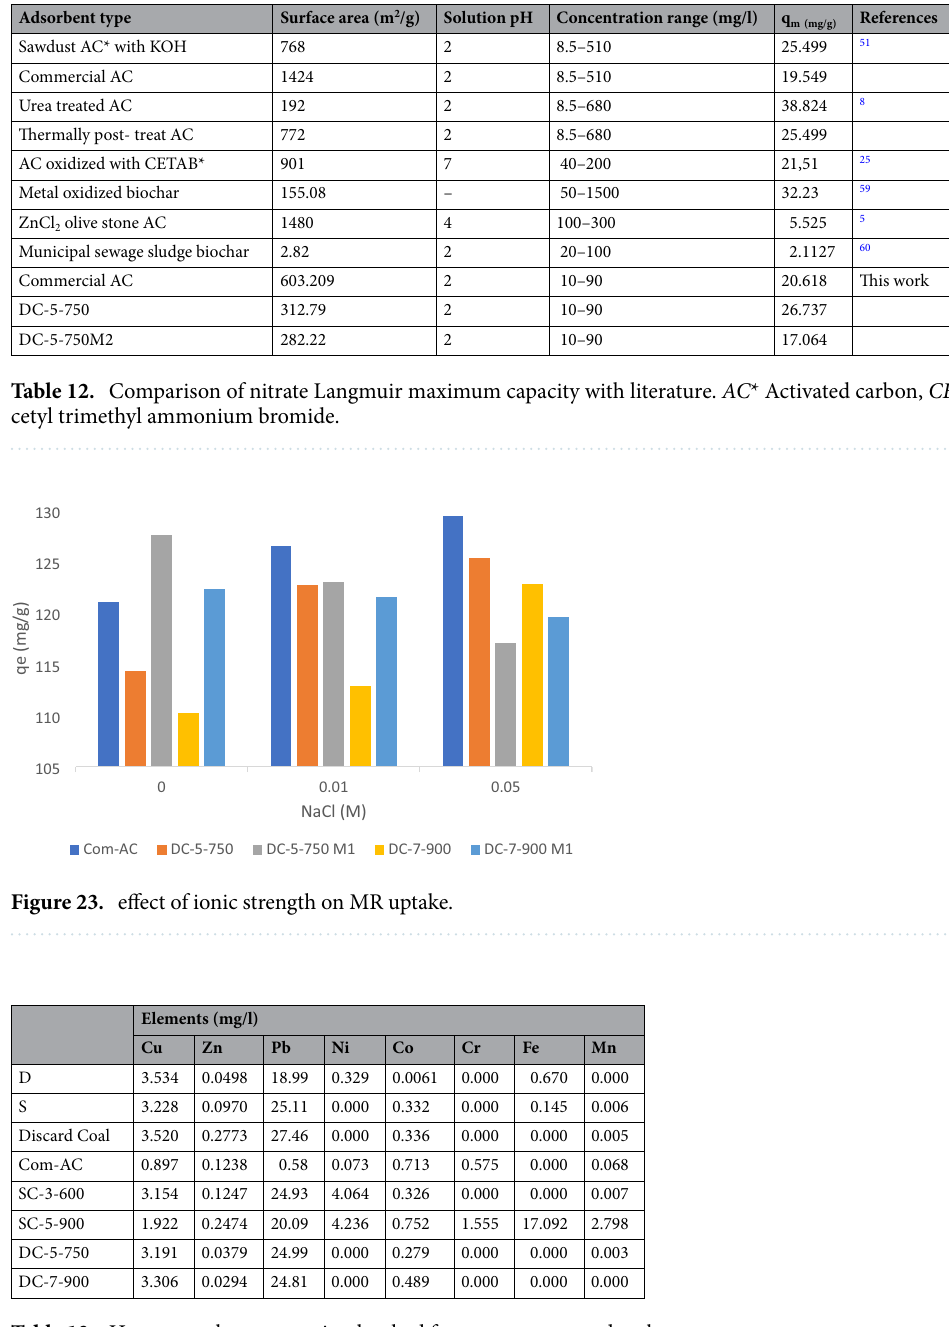
Table 13. Heavy metal concentration leached from precursors and